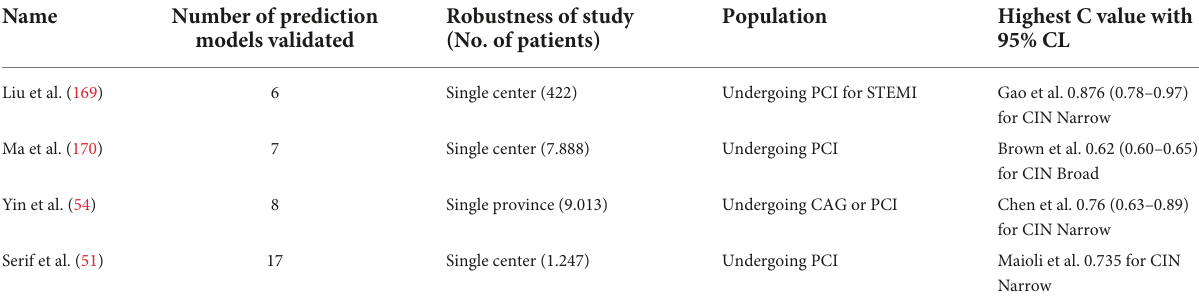
TABLE 1 External validation and comparative studies of risk stratification